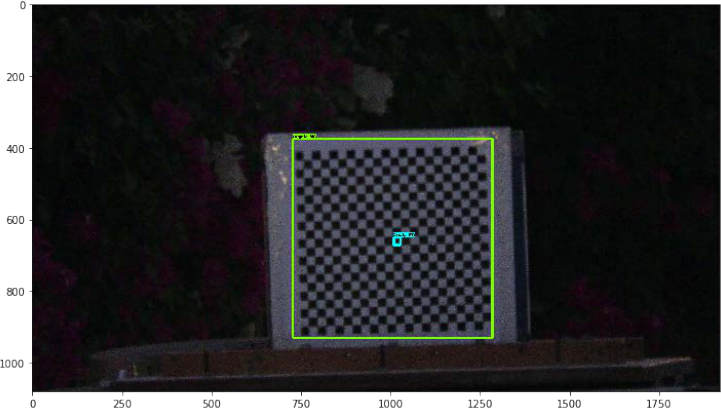
Figure 16. Example of a frame of monitoring video sequence at very low light exposure.